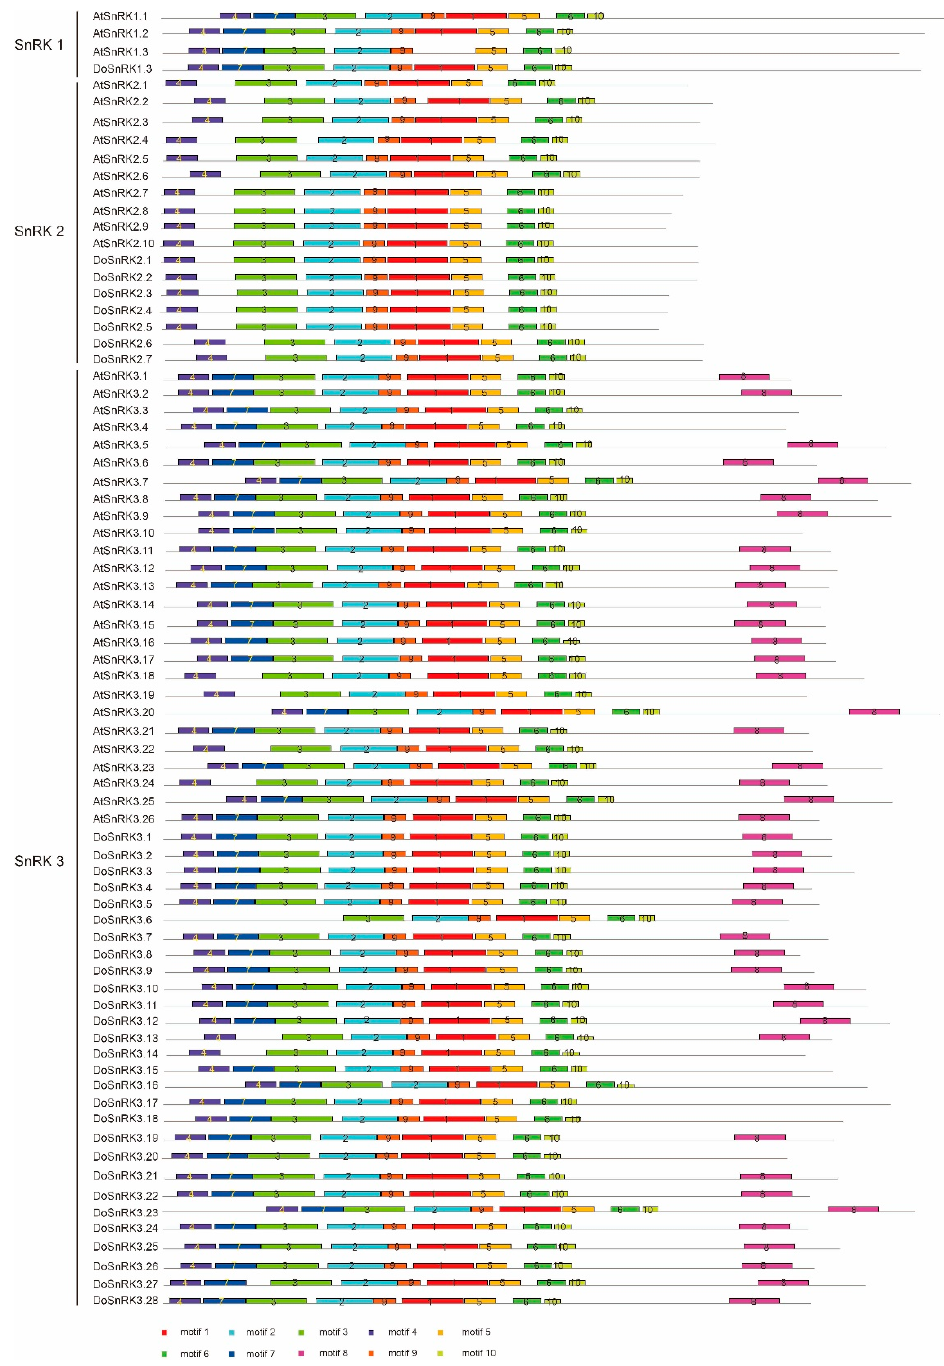
Figure 4. The conserved motifs of SnRK proteins predicted using Multiple Em for Motif Elicitation (MEME). The colored rectangles with numbers stand for 10 conserved motifs/ and the gray lines are non-conserved sequences.